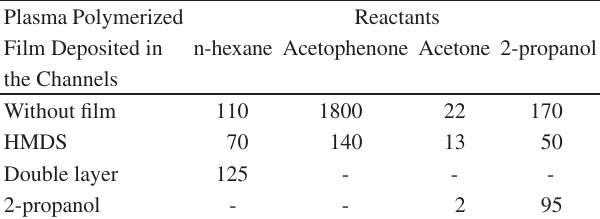
Table 7. Frequency variation ( ∆ F - Hz) obtained on the detector after injection of reactants in spiral shape